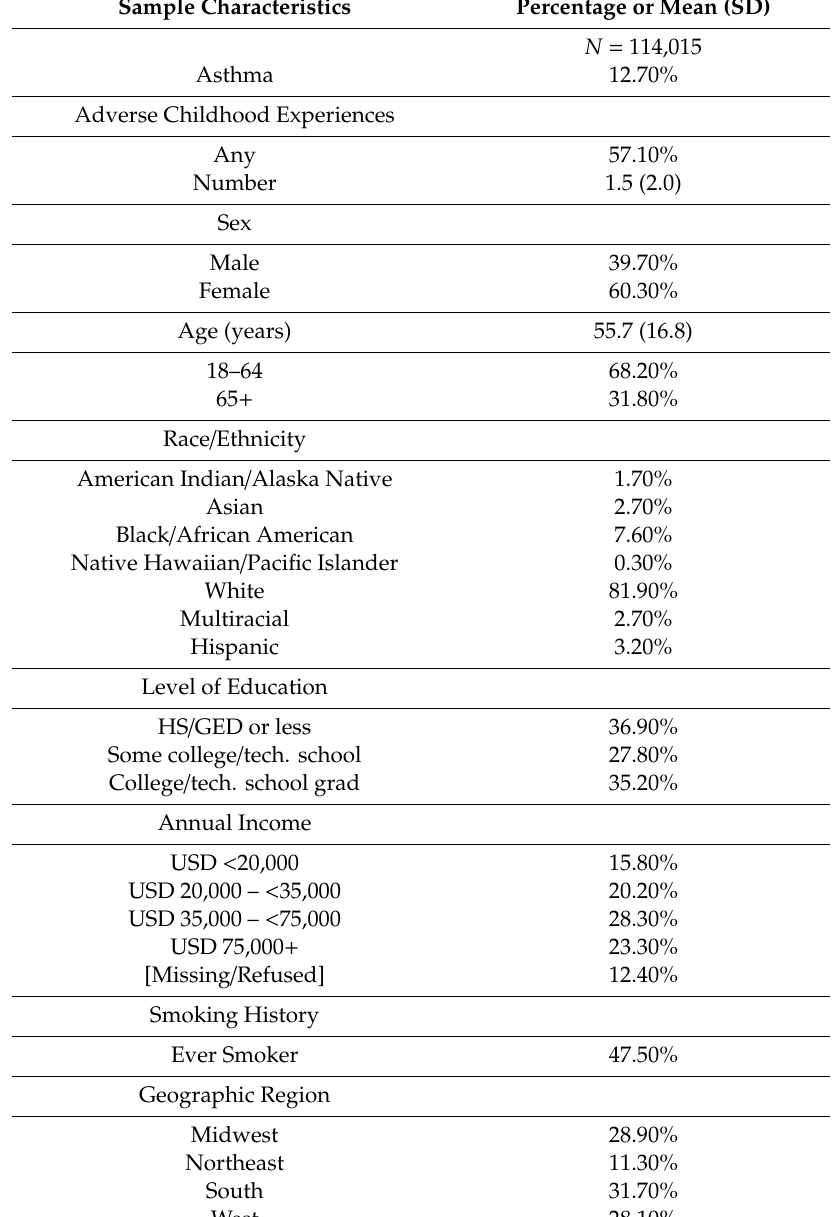
Table 2. Sample characteristics, Behavioral Risk Factor Surveillance System 2009 to 2012 adverse childhood experiences module